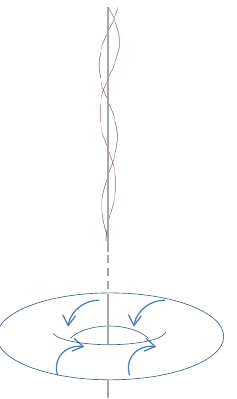
Fig. 18. Far-¯eld, near-axis °ow of a swirl vortex ring that can be approximated as a vortex